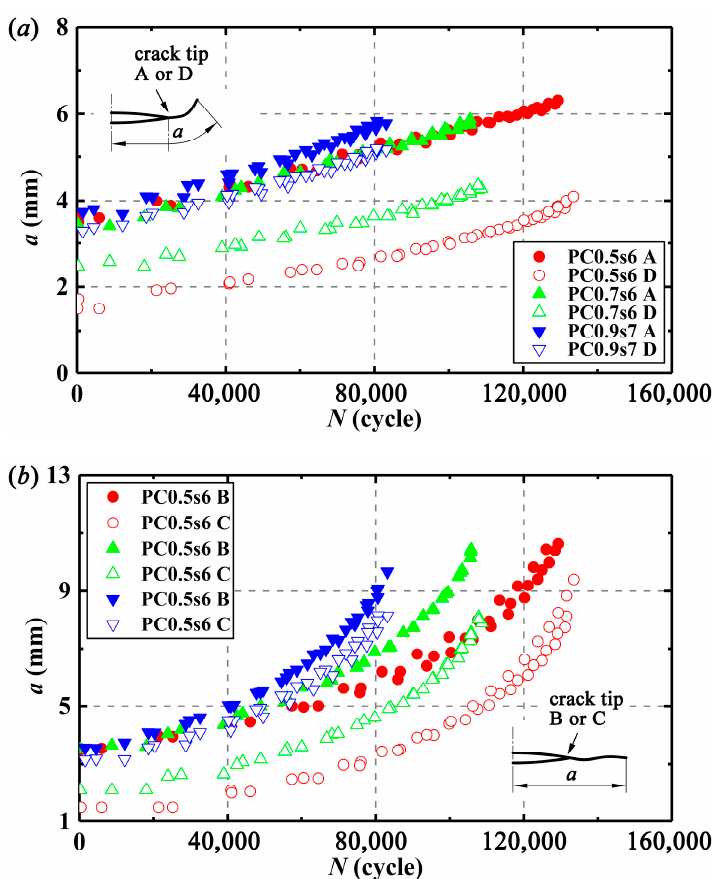
Figure 5. Crack growth length vs. cycle number: ( a ) inner crack tips of the double unequal cracks and ( b ) outer crack tips of the double unequal cracks.